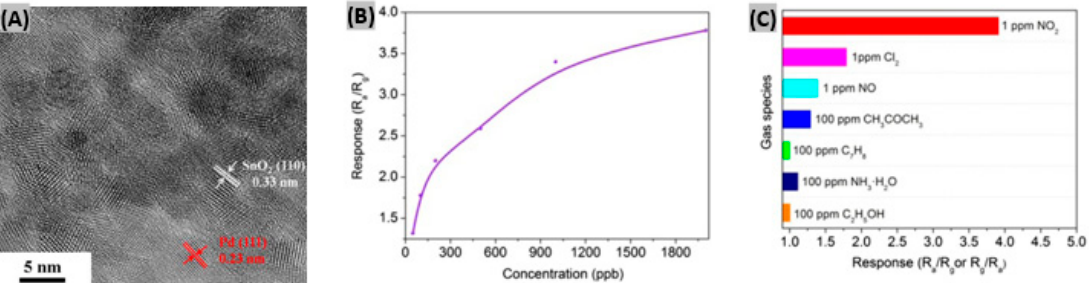
Figure 1. ( A ) HR-TEM image of fabricated Pd-SnO 2 -RGO hybrid. ( B ) Sensor response toward different concentrations of NO 2 gas at room temperature. ( C ) The response of the sensor to Cl 2 , NO, NO 2 , acetone, toluene, ammonia and ethanol in a selectivity test. Figures adapted with permission from [67], Copyright 2018 Elsevier.